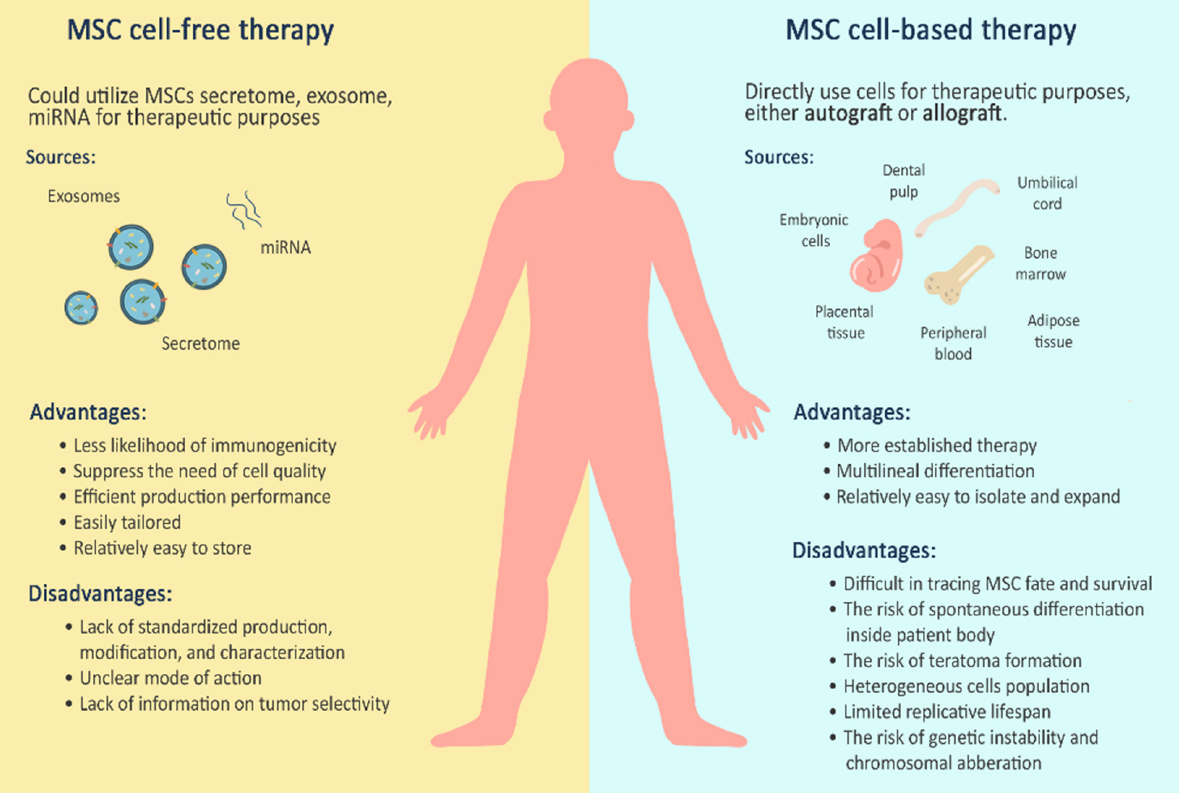
Figure 3. Two main groups of stem cell therapeutic approaches for COVID-19 therapies. Cell-based therapies and cell-free therapies have different benefits and risks that need careful consideration for the development of safe and effective COVID-19 therapies.